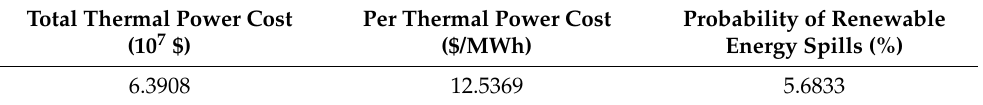
Table 3. Operation indices.